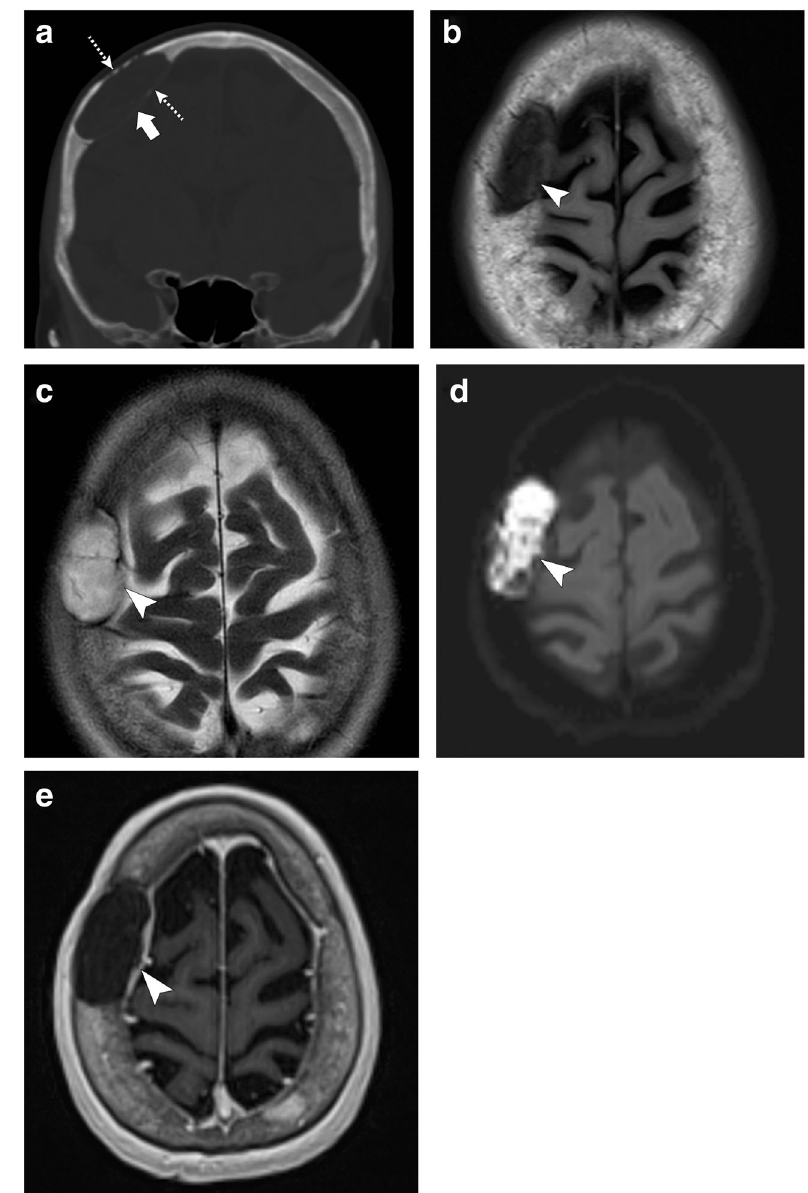
Fig. 13 Epidermoid cyst. Axial head CT portrays an expansile lesion in the right frontal bone ( thick arrow ) with thinning of the inner and outer tables ( dashed arrows ). Axial T1-weighted imaging ( b ), axial T2-weighted imaging ( c ), axial DWI ( d ) and axial post contrast T1-weighted imaging ( e ) show that the lesion is hypointense on T1, hyperintense on T2 with restricted diffusion and absent internal enhancement ( arrowheads ). Note that there may be some enhancement along the peripheral